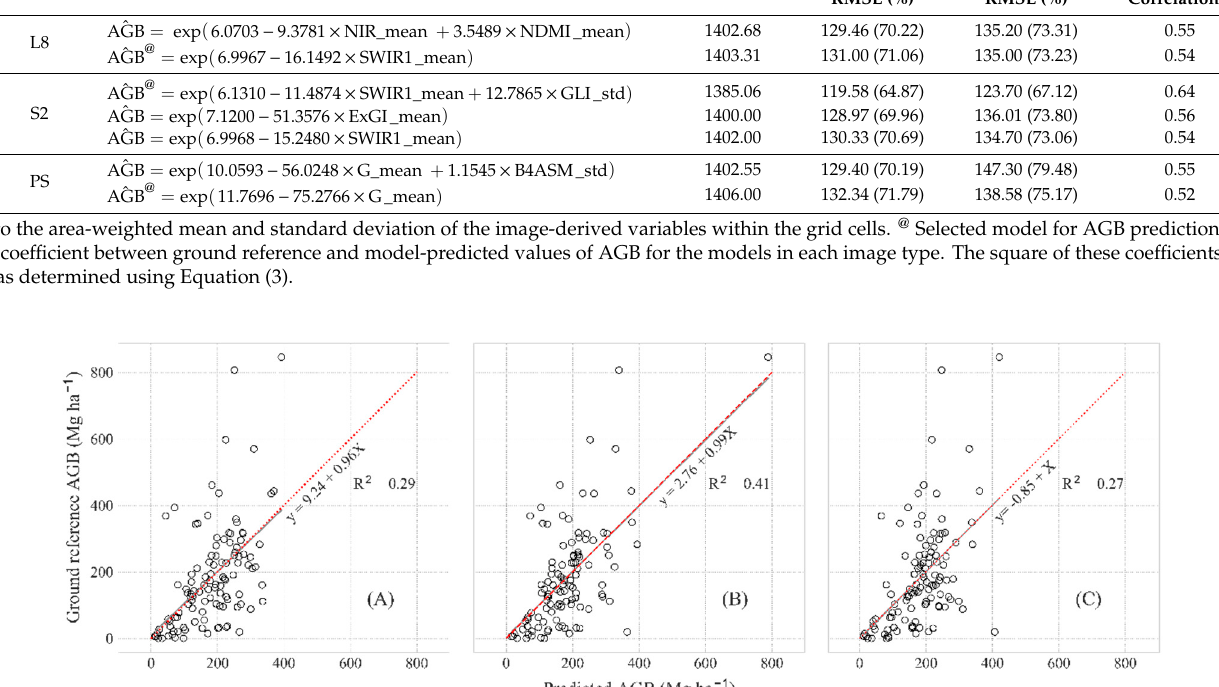
Table 5. Models and performance indicators for mean AGB estimation in the Degaga-Gambo forest using independent variables from L8, S2 and PS images.